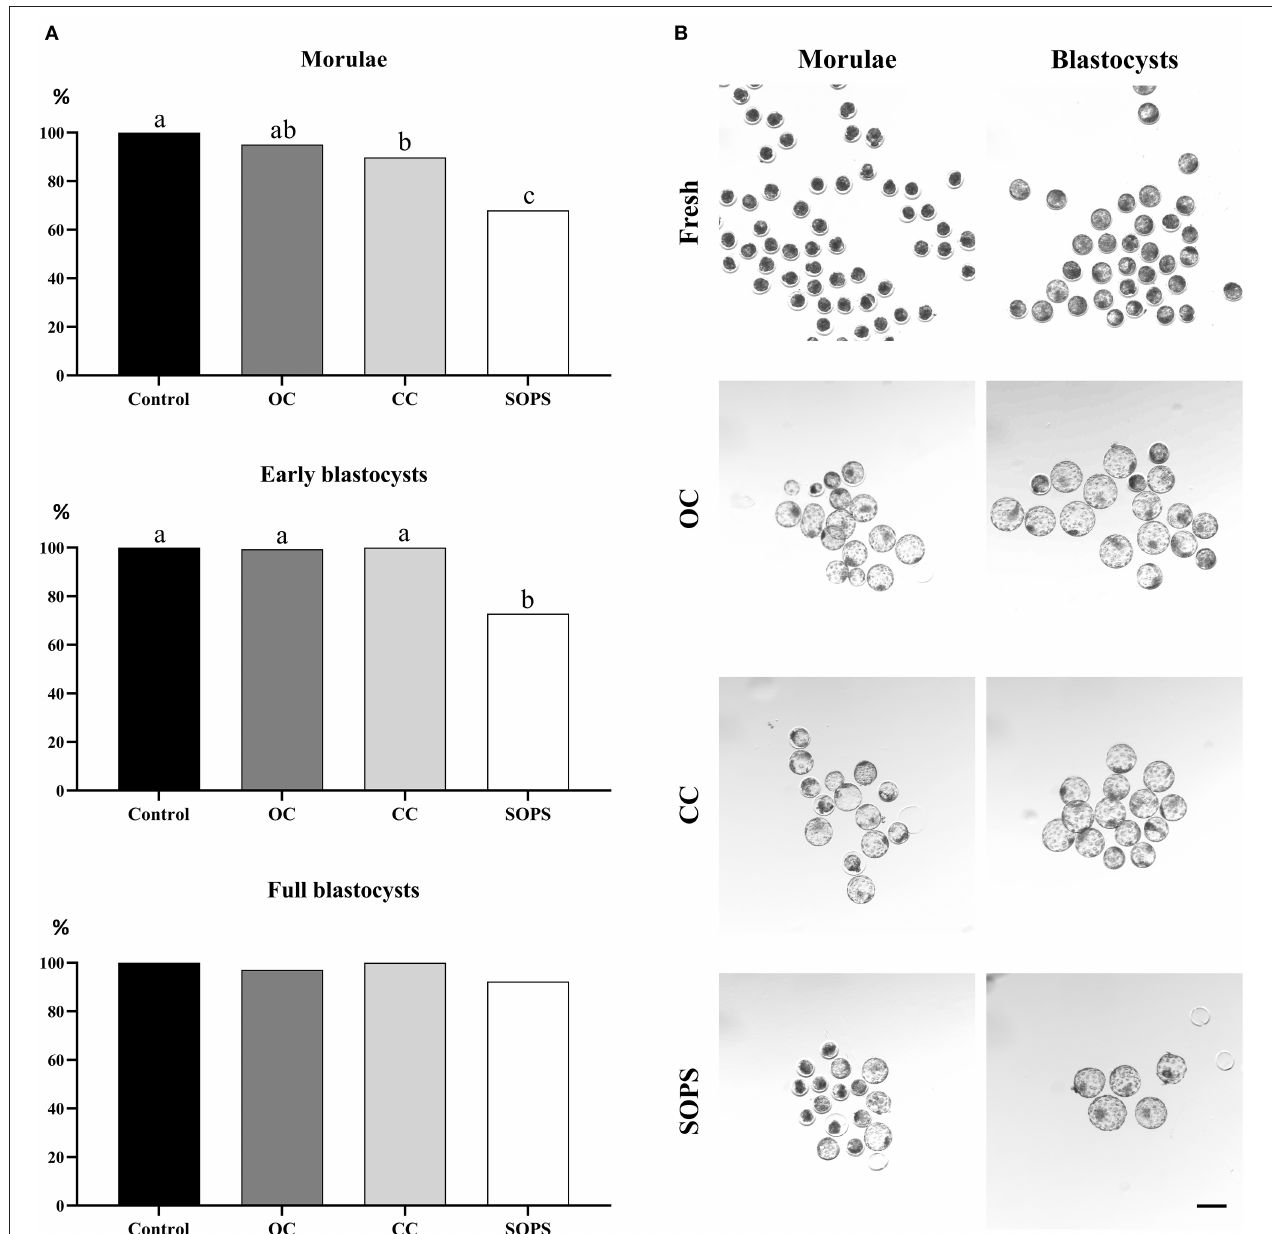
FIGURE 3 | Embryo survival after vitrification and warming. (A) Postwarming survival rates of morulae ( n = 283), early blastocysts ( n = 283), and full blastocysts ( n = 137) vitrified with open Cryotop ® (OC), closed Cryotop ® (CC) and SOPS systems. a,b,c p < 0.01. (B) Representative images of in vivo -derived morulae and blastocysts prior and after vitrification with the different systems. Scale bar: 200 µ